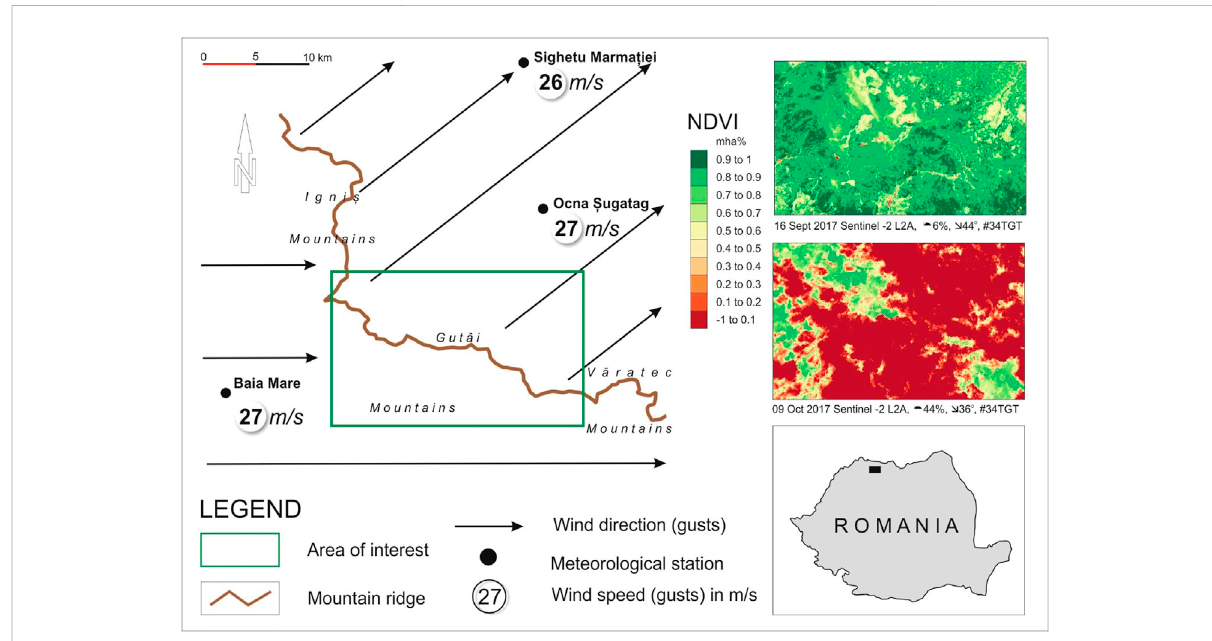
FIGURE 2 NDVI for the AOI of the study area, before (16.09.2017) and after the storm (09.10.2017), Sentinel 2L 2A at